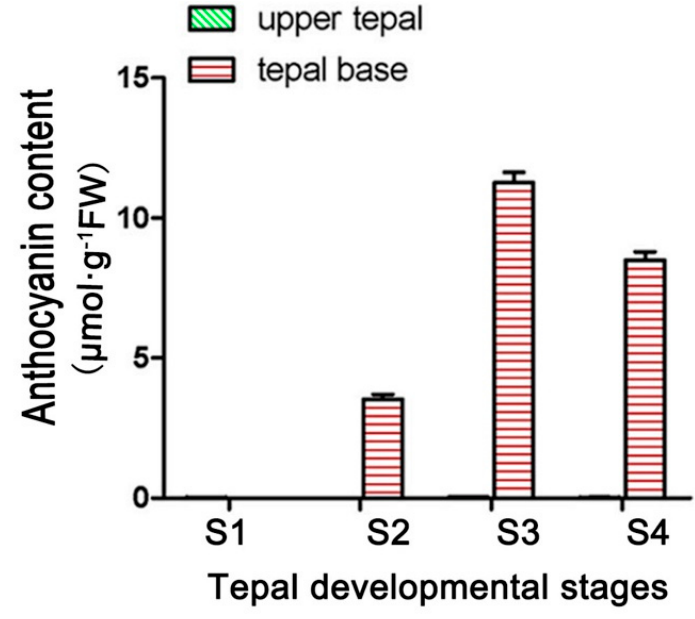
Figure 6. Changes in anthocyanin content at different developmental stages in Lilium [21].